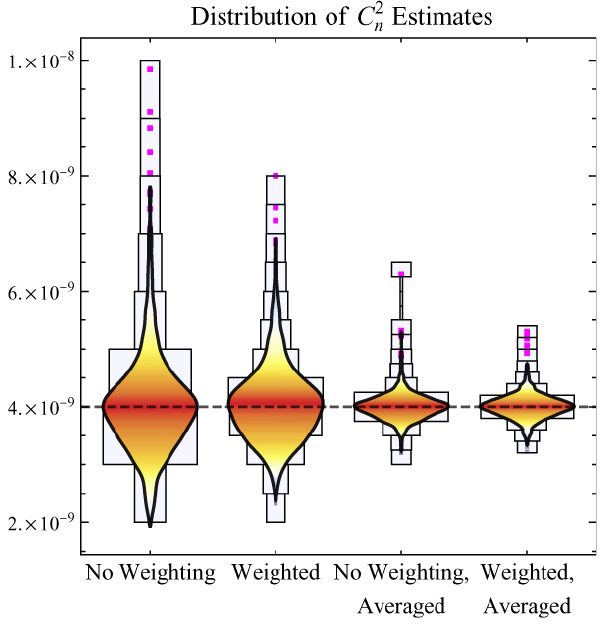
Fig. 8. Distribution of C 2 η 1η estimates over 1000 realization. The dashed horizontal line is the true